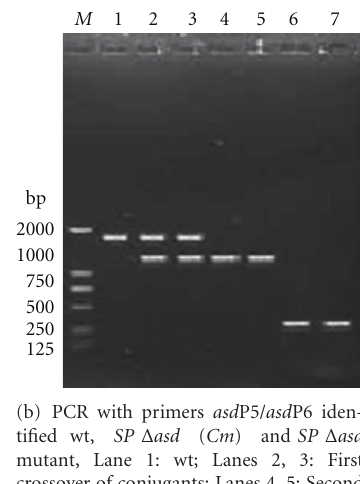
(b) PCR with primers asd P5/ asd P6 iden- tified wt, SP Δ asd ( Cm ) and SP Δ asd mutant, Lane 1: wt; Lanes 2, 3: First crossover of conjugants; Lanes 4, 5: Second crossover of conjugants (the SP Δ asd ( Cm ) mutant); Lanes 6, 7: the SP Δ asd mutant. Figure 5: PCR identification of the SP Δ asd ( Cm )